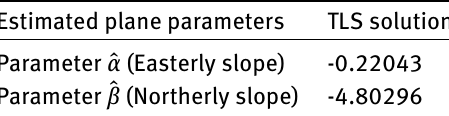
Table 12: Eigenvalue solution from